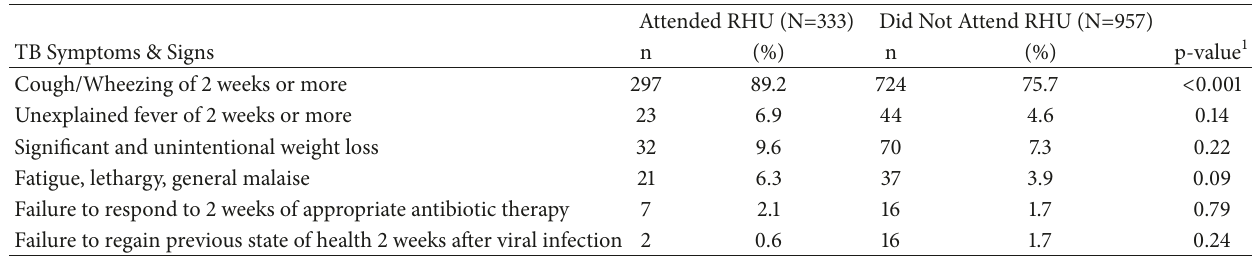
Table 2: TB symptoms and signs of study participants divided by those who attended RHU for TB testing and those who did not attend RHU and did not get tested for TB.